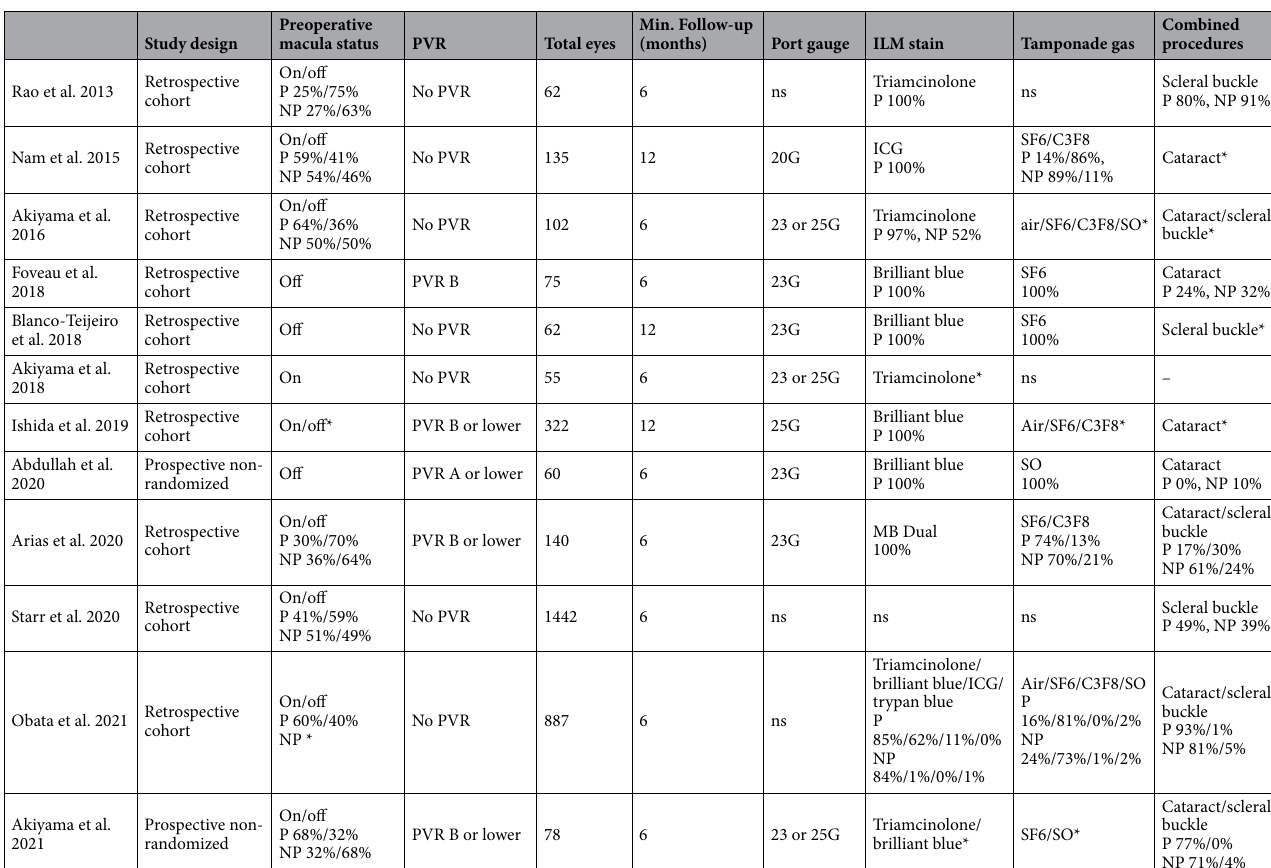
Table 1. Summary of the main characteristics of the studies included in the review. ns, not specified; PVR, proliferative vitreoretinopathy; Min., minimum; ILM, internal limiting membrane; ICG, indocyanine green; SF6, sulphur hexafluoride; C3F8, perfluoroctane; SO, silicone oil. P, ILM-peeling group. NP, non ILM-peeling group. *Percentage not specified in source study.